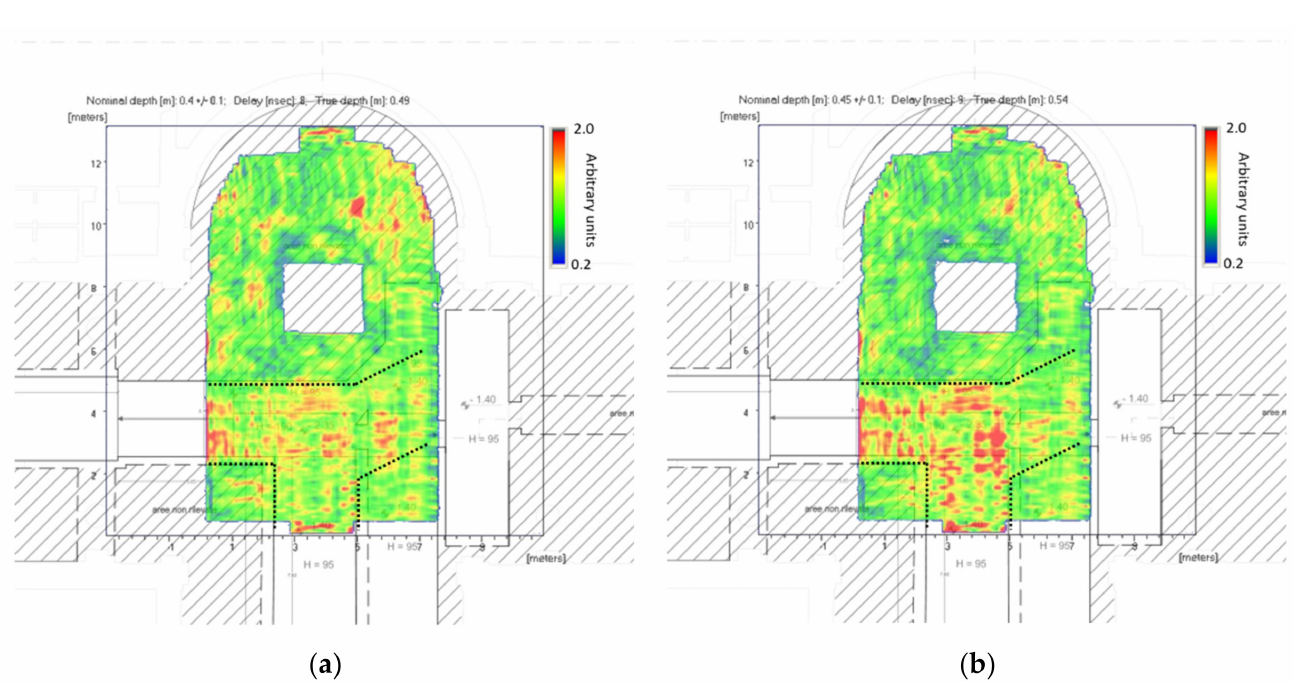
Figure 12. C-scan: ( a ) 0.41 m depth; ( b ) 0.52 m depth. The dotted line corresponds to the air-conditioning